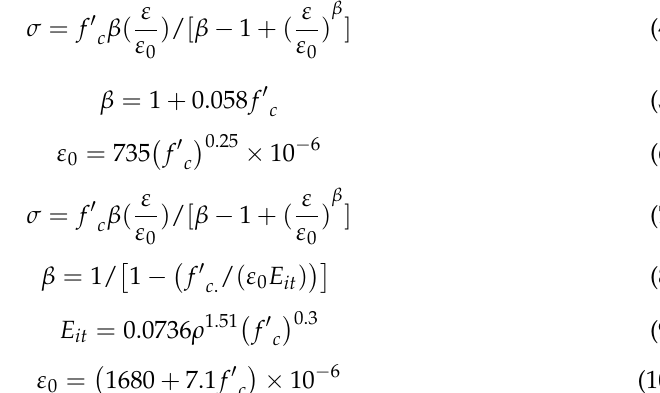
Figure 19. Toughness and ductility values for the control, R7 and R8 mixes.